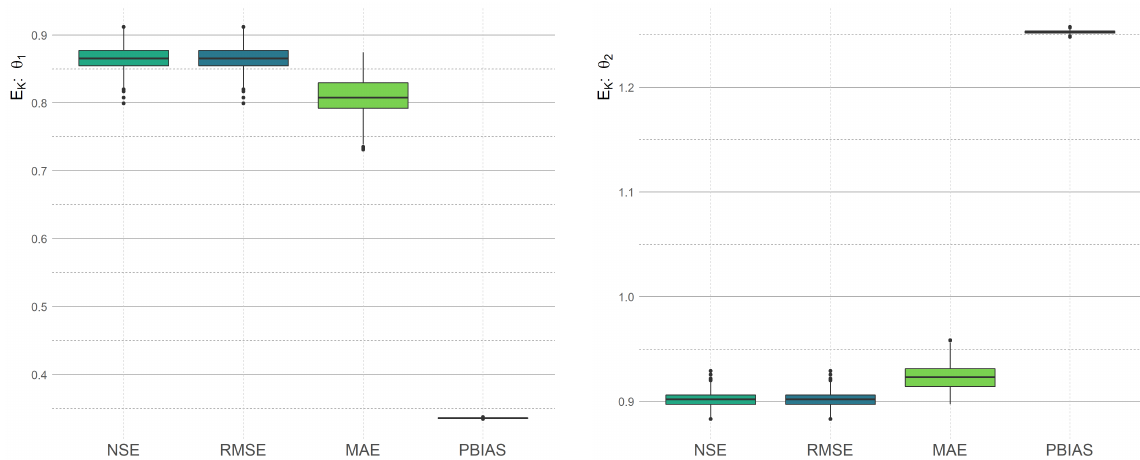
Figure 5. The comparison of the calibrated Kharrufa model parameters obtained by the cross-validation calibration process on training data with respect to various statistical measures.